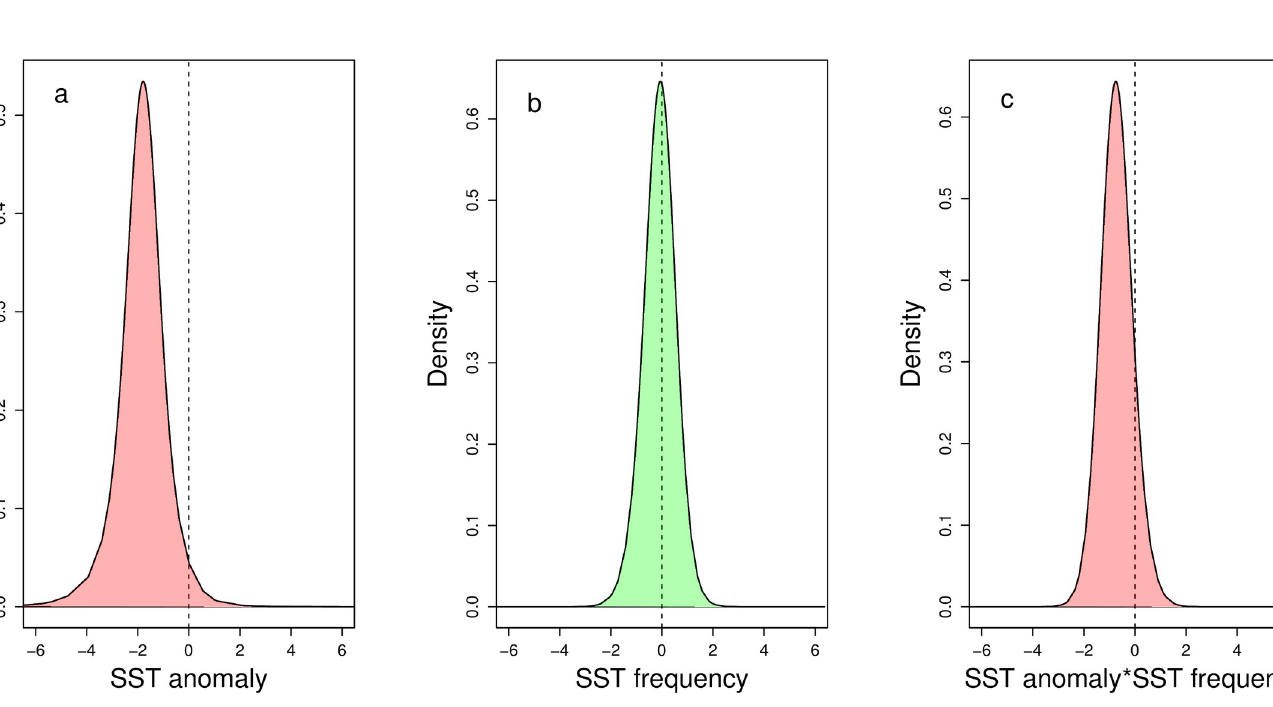
PLOS ONE | https://doi.org/10.1371/journal.pone.0249008 April 26,